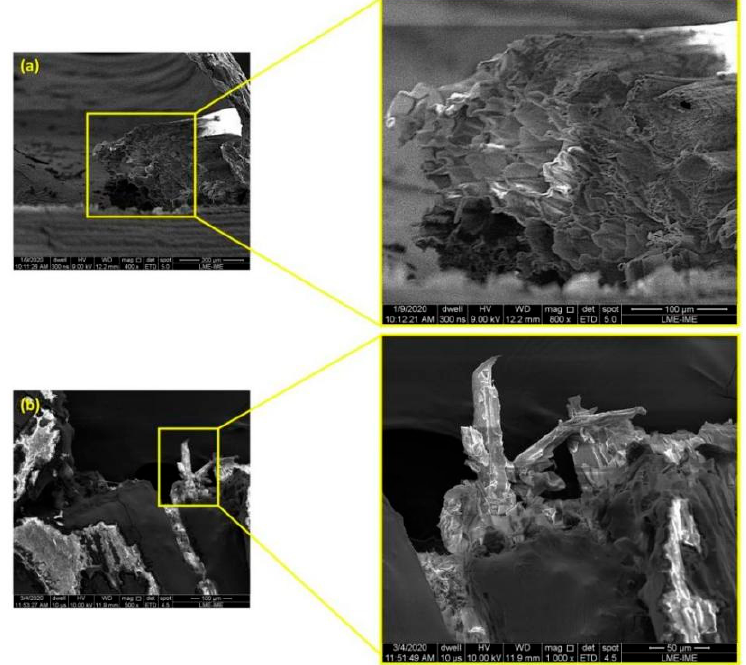
Figure 6. Micrograph of the fracture surface of sedge fiber: ( a ) fracture surface indicating the microfibrils. Magnification 400 and 800×; ( b ) fiber rupture under tensile stress. Magnification 500 and 1000×.